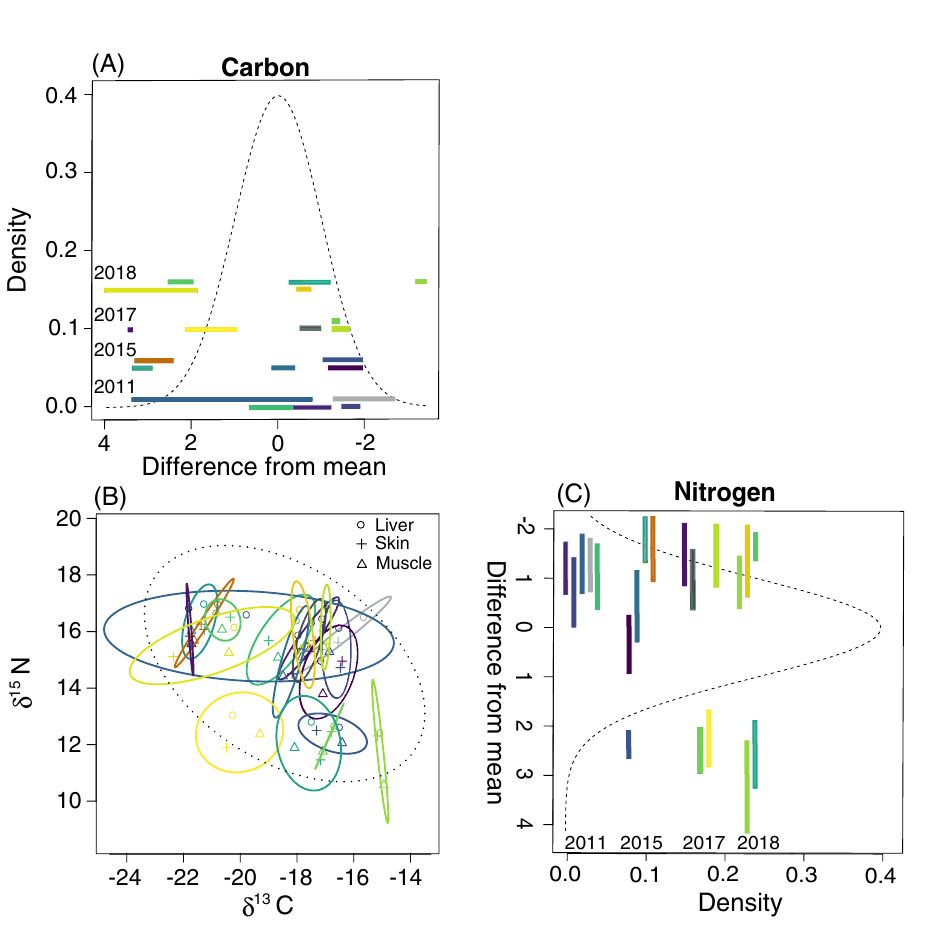
Figure 4. Individual variation in δ 13 C ( A ) and δ 15 N ( C ) values of stranded dolphins from Alabama. Ellipses ( B ) represent the 95% confidence intervals of δ 13 C and δ 15 N values in each individual calculated using three tissue types (liver, skin, muscle). Each color corresponds to an individual, with ellipse size corresponding to isotopic niche size. The black, dotted ellipse reflects the niche size for all tissues from all individuals. The normal distributions of our δ 13 C and δ 15 N values are presented as the dashed lines in ( A ) and ( B ), respectively. For ( A ), the panel has been presented as the mirror image of the original because the negative values associated with δ 13 C flip the signs of the differences (i.e., − to + and + to −) when subtracted from the mean, which explains why the x-axis goes from positive to negative. The colored bars in ( A ) and ( B ) indicate the range of differences between the mean δ 13 C (− 18.4‰) or δ 15 N (14.9‰) value and each tissue for every individual. Individuals were organized by year along the y-axis to help space the colored bars and prevent them for overlapping and are not related to the values on the